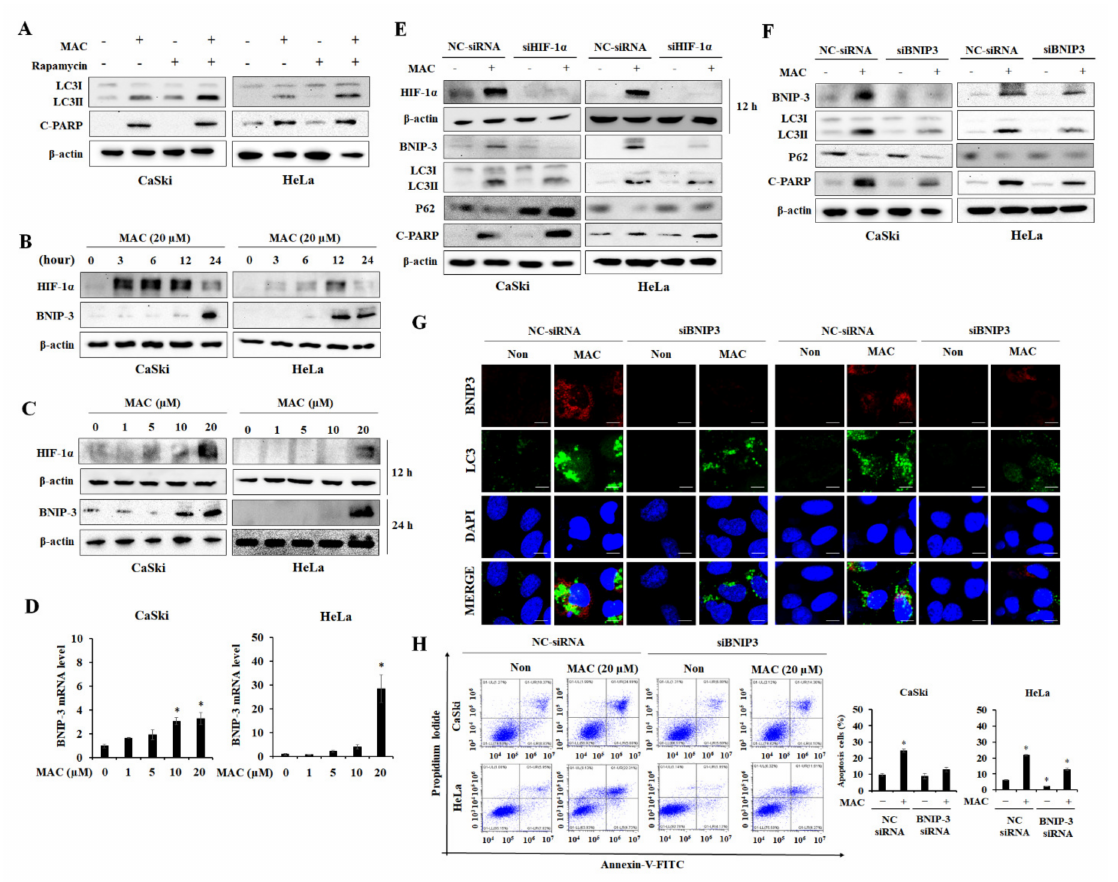
Figure 4. MAC-induced autophagy and apoptosis are regulated by Bcl-2/adenovirus E1B 19 kDa protein-interacting protein 3 (BNIP-3) expression rather than rapamycin and Hypoxia-inducible factor 1 alpha (HIF-1 α ) in cervical carcinoma cells. ( A ) Cells were treated with MAC (20 µ M) for 24 h in the presence or absence of the rapamycin (1 µ M), then protein levels of LC3 and cleaved-PARP were determined by Western blot analysis. ( B ) After the cells were treated with 20 µ M of MAC, the protein levels of HIF-1 α and BNIP-3 were checked for each indicated time (0, 3, 6, 12 and 24 h). ( C ) Cells were treated with various dose of MAC (0, 1, 5, 10 and 20 µ M) for 12 h and 24 h, then Western blotting analyzed with antibodies against HIF-1 α and BNIP-3, respectively. ( D ) Cells were incubated with concentration of MAC (0, 1, 5, 10 and 20 µ M) for 24 h, then mRNA level of BNIP-3 was checked by RT-PCR analysis. ( E ) CaSki and HeLa cells were transfected with negative siRNA and HIF-1 α siRNA then treated with MAC for 24 h. Subsequently, cell pellets were collected for Western blot to examine proteins levels of BNIP-3, LC3, p62 and cleaved-PARP. HIF-1 α and its corresponding β -actin were confirmed after 12 h of treatment with MAC. ( F ) Cells were transfected with negative siRNA and BNIP-3 siRNA then treated with MAC for 24 h, the protein levels of BNIP-3, LC3, p62 and cleaved-PARP were examined by Western blot analysis. ( G ) After knockdown under the same conditions as ( F ), immunofluorescence analysis was performed using LC3-antibody (green) and BNIP-3 (red). All nuclei were stained using DAPI (blue). Scale bars were 10 µ M. ( H ) The apoptotic cells were verified by PI/Annexin V-FITC staining. Values represent the mean ± SD of triplicate assays. * p < 0.05 vs. negative control. Results were analyzed using one-way ANOVA followed by Bonferroni post hoc